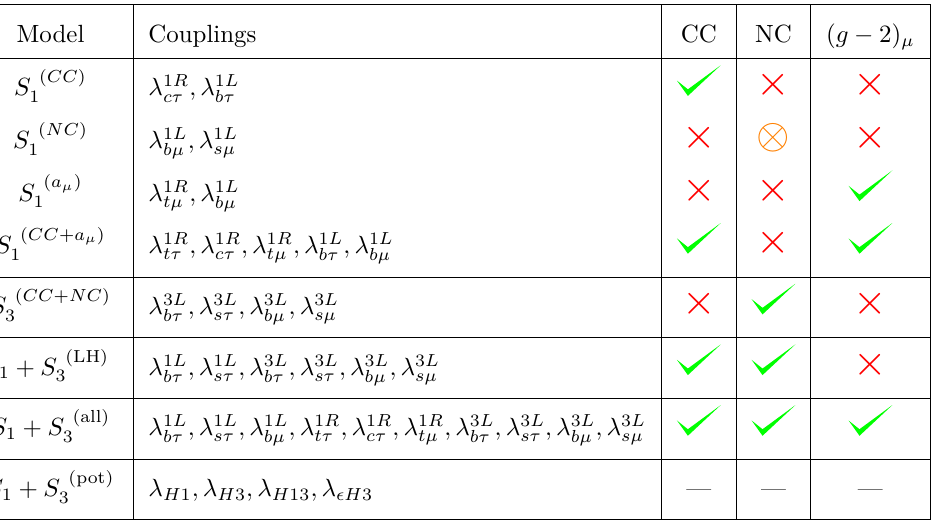
— — — Table 4 . Summary of leptoquark models considered in this work. The third columns lists the couplings we allow to be different from zero in our global fit. The last three columns indicate whether the models provide a satisfying fit of each set of anomalies,